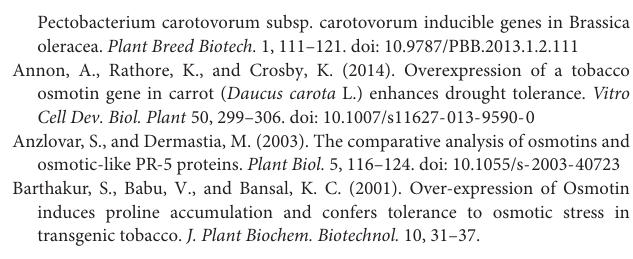
S. nigrum osmotins. Osmotin group is pink coloured according to posterior probability values. Supplementary Table 1 | Primer set designed for